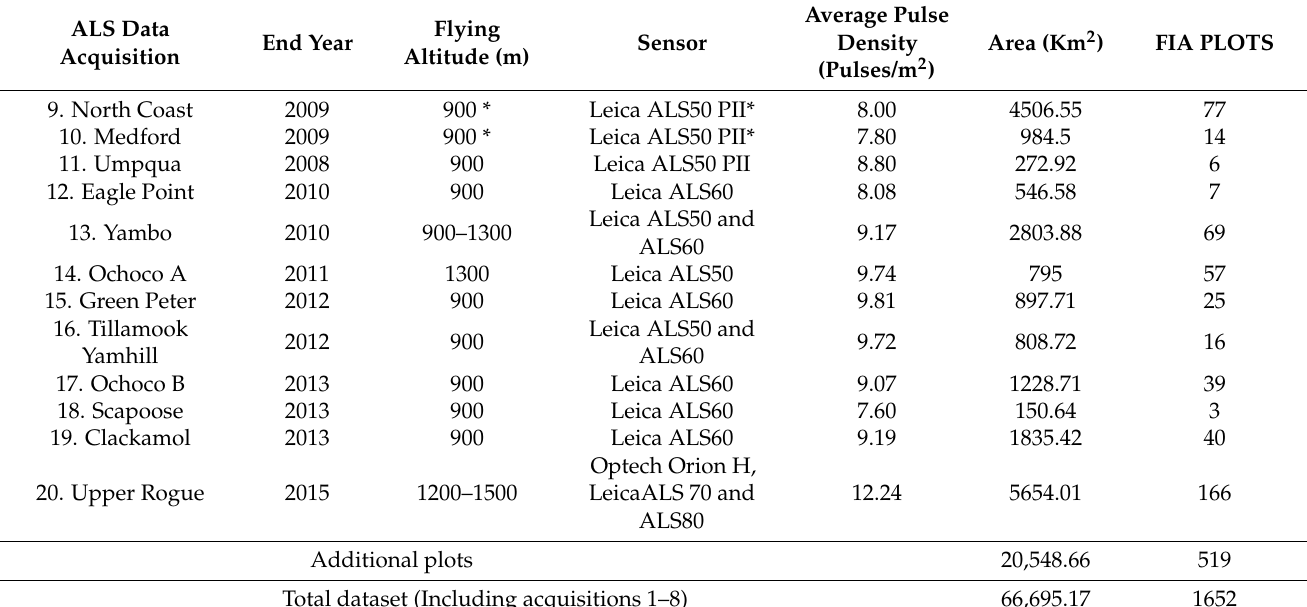
Table A1. Additional ALS data acquisitions summary and number of field plots per ALS acquisition. * Data collection date not reported by vendor; flying altitude and sensor inferred from the data reported for acquisitions obtained the same year.